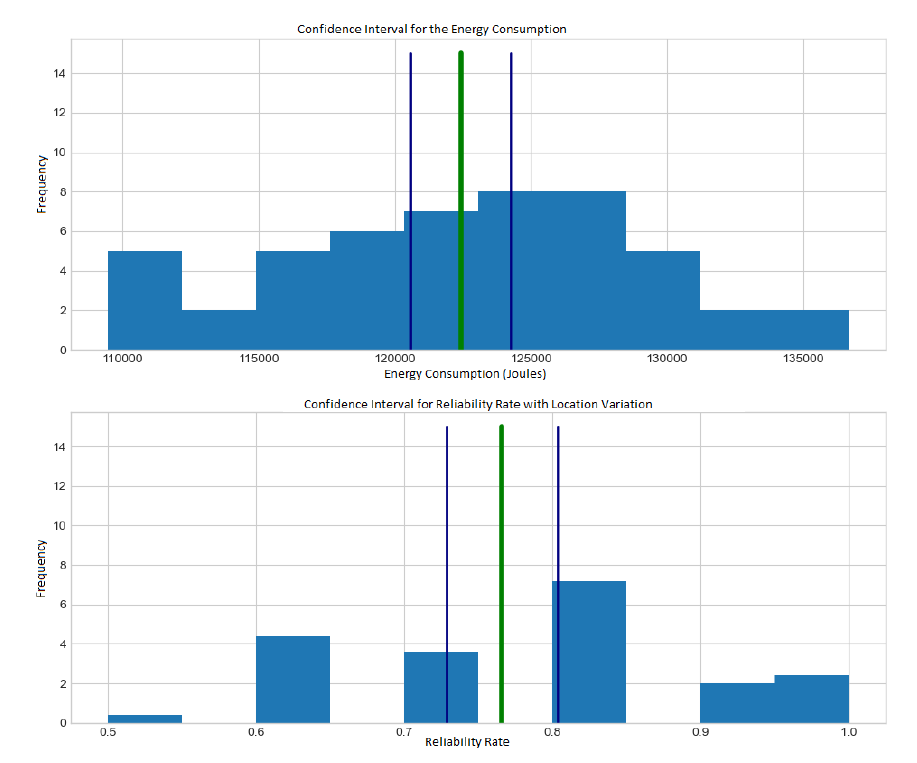
Figure 7. Histogram with energy consumption and reliability rate varying locations. A constant autonomy is maintained, allowing all instances to return an optimal solution to measure the response time and energy consumption metrics. For simulations with autonomy variation, a random value is generated between 35, 000 and 60, 000